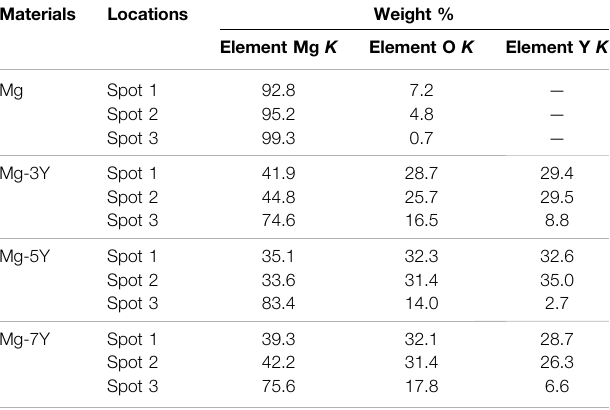
TABLE 6 | The elemental composition of different cross-section locations.